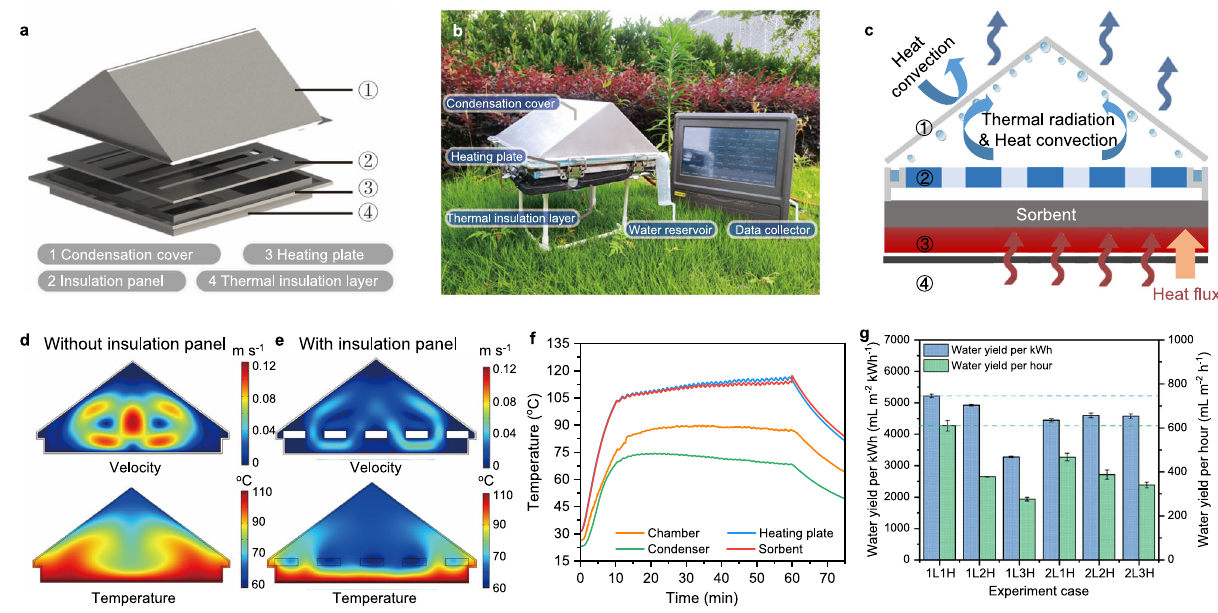
Fig.3|Designandoptimizationofsorption-basedwaterharvester.a 3Drender of the designed portable sorption-based water harvester. b Photo of the water harvester and the data collector. c Energy balance of the SAWH device during the water release-condensation process. d Velocity and temperature distribution inside the device without the insulation panel. e Velocity and temperature